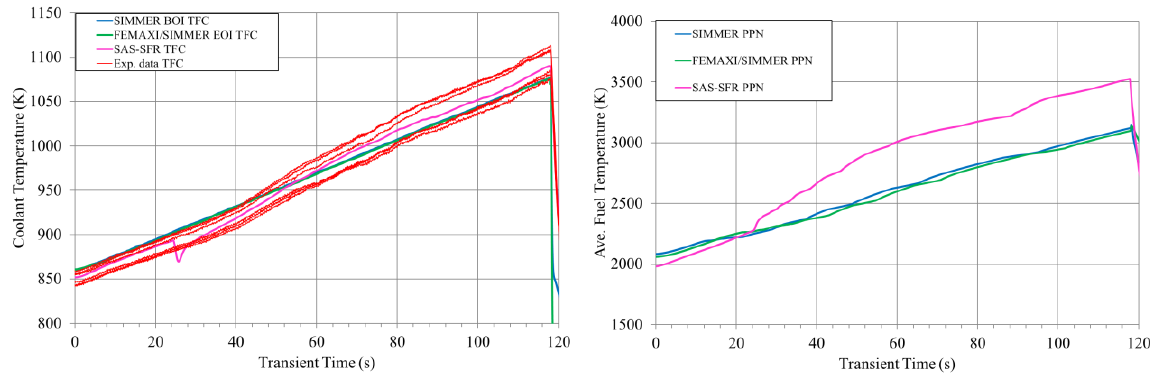
Figure 1. Na temperature at TFC Figure 2. Average fuel temperature at PPN